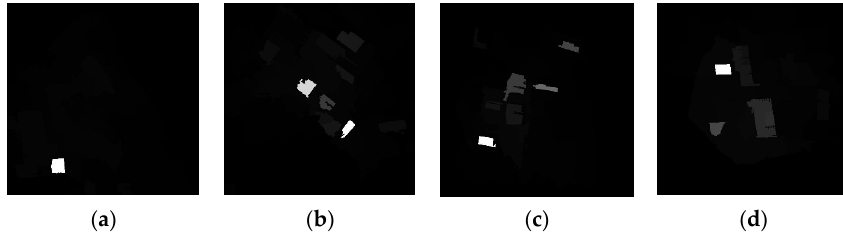
Figure 8. Local contrast saliency maps. ( a ) Image I, ( b ) Image II, ( c ) Image III, ( d ) Image IV.